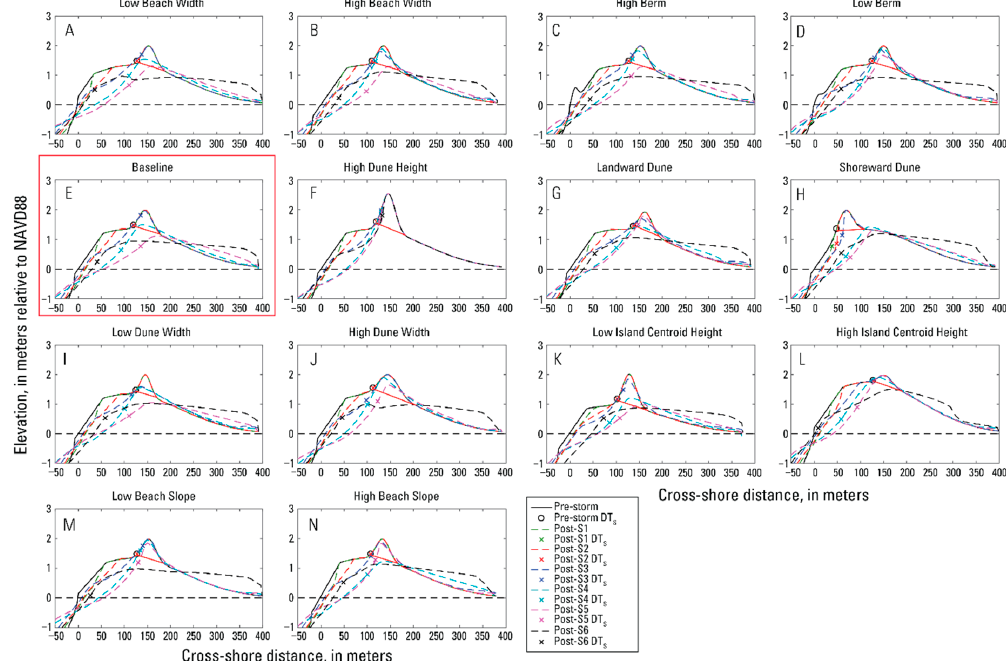
Figure 6. 1D pre- and post-simulation profiles for all 6 storm scenarios with shoreward dune toe position (DT s ) identified. ( A ) low beach width case, ( B ) high beach width case, ( C ) high berm height case, ( D ) low berm height case, ( E ) baseline case, ( F ) high dune height case, ( G ) landward positioned dune case, ( H ) shoreward positioned dune case, ( I ) low dune width case, ( J ) high dune width case, ( K ) low island centroid height case, ( L ) high island centroid height case, ( M ) low beach slope case, and ( N ) high beach slope case. Horizontal dashed line denotes the 0 m elevation line for reference. Red line indicates dune footprint area examined in post-storm analyses for dune volume and width changes.